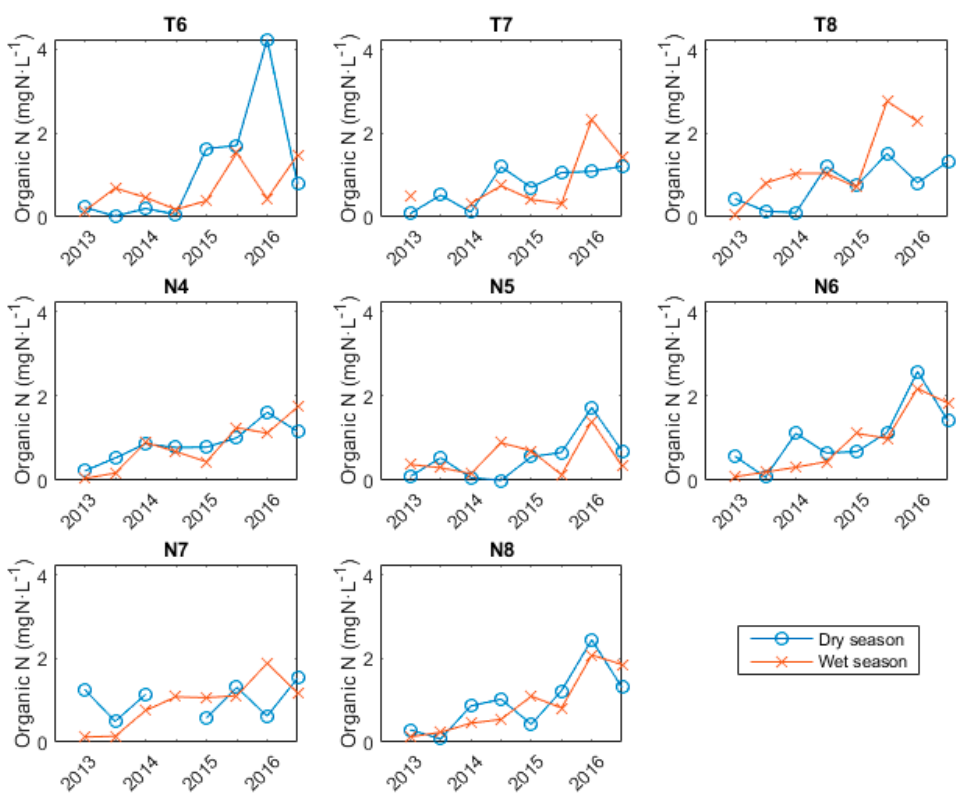
Figure 6. Organic nitrogen concentrations between 2013 and 2016 in the dry (blue) and wet (red) season; 2 values are shown per season.